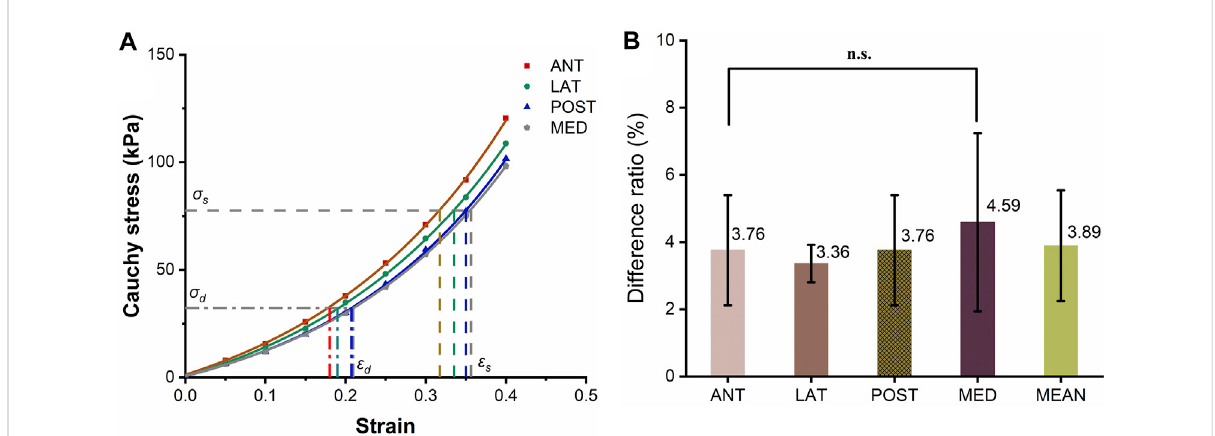
FIGURE 6 Circumferential stress-strain curves of the ascending artery. (A) Stress-strain curves of the anterior (ANT), lateral (LNT), posterior (POST) and medial (MED) quadrants around the circumference of the artery. The horizontal and vertical lines represent the values of stresses and strains calculated using a physiological range of 50/120 mmHg BP for pigs. (B) Histogram of the differences in strain energy within the physiological range estimated by linear and integral approximations. The fi ve columns represent the ratio of the linear to integral estimates of stress-strain area for the anterior (ANT), lateral (LNT), posterior (POST) and medial (MED) quadrants and the mean difference, with the values marked above each column. The label n.s. indicates no signi fi cant difference among the four